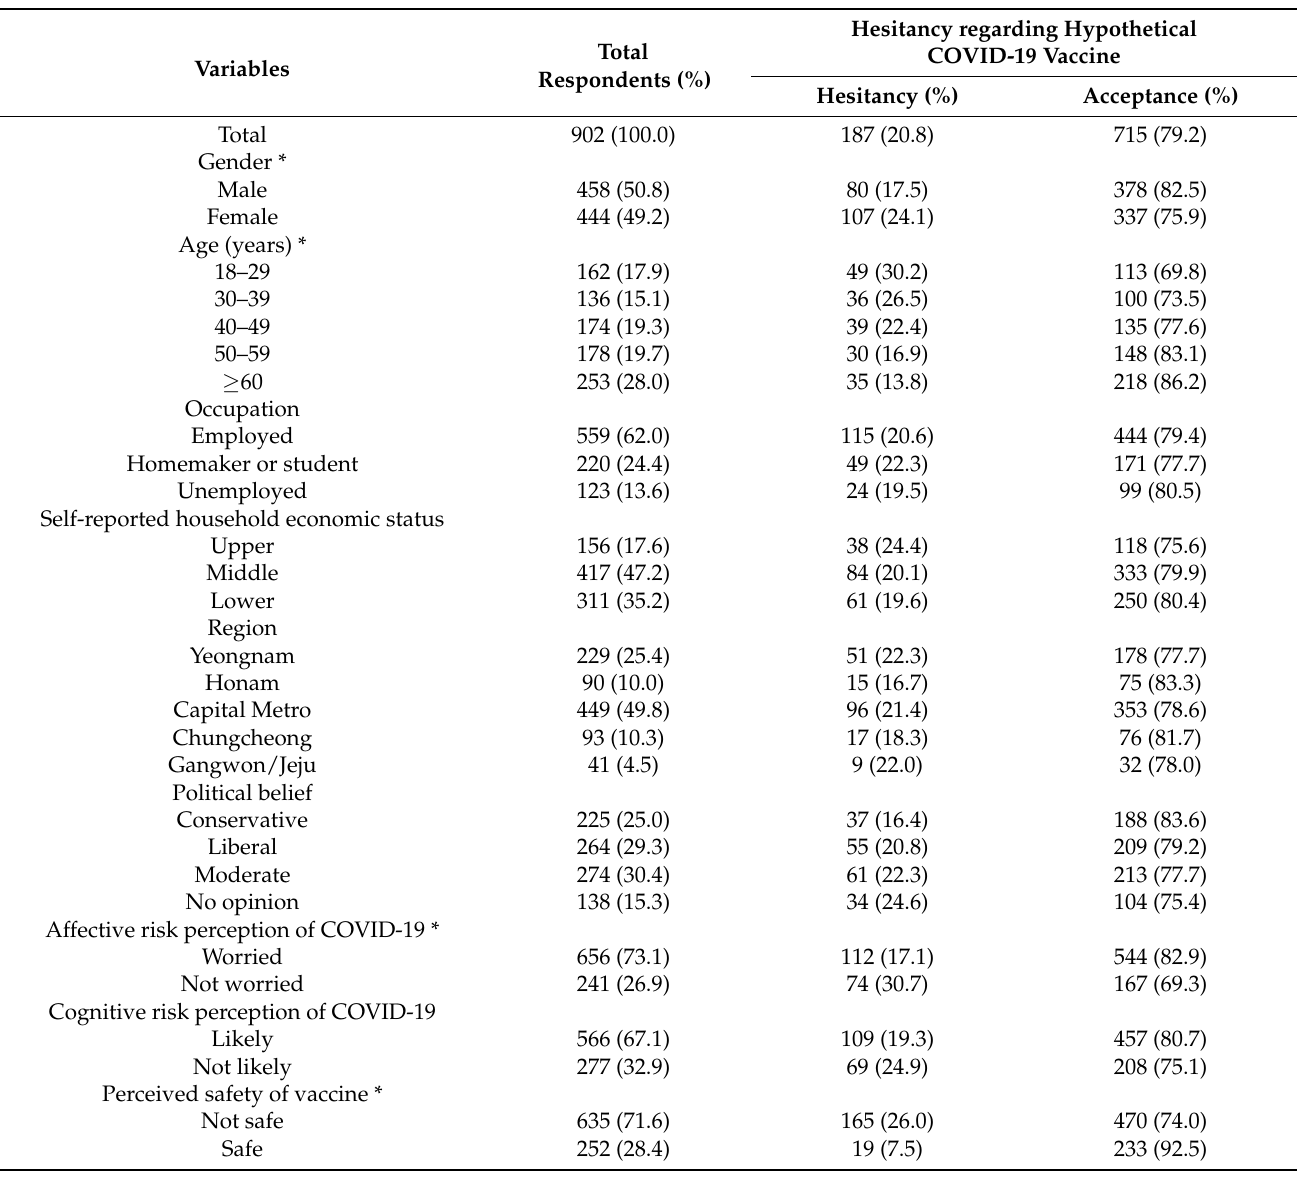
Table 1. Respondents’ general